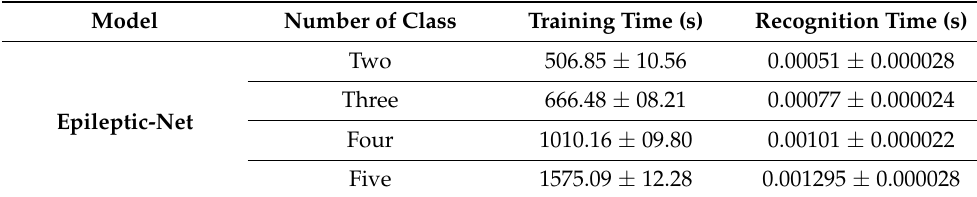
Table 7. Runtime comparison of Epileptic-Net model for each class.